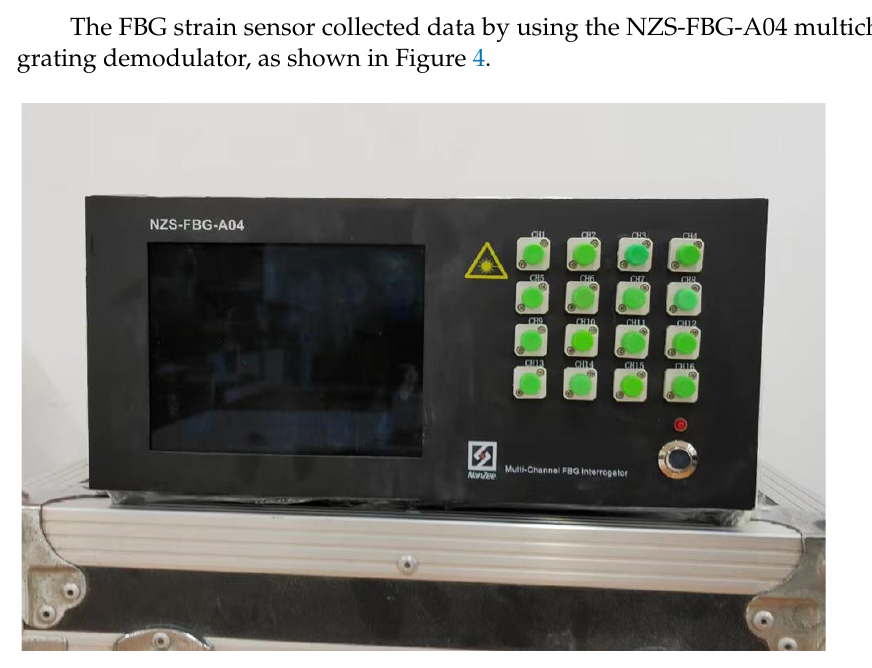
( b ) Figure 5. Installation diagram of FBG strain sensor: ( a ) front side and ( b ) rear side.